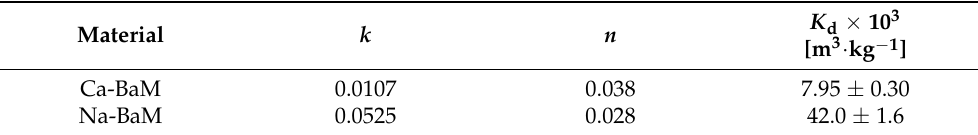
Table 2. Extrapolation of K d value from batch sorption experiments for the conditions corresponding